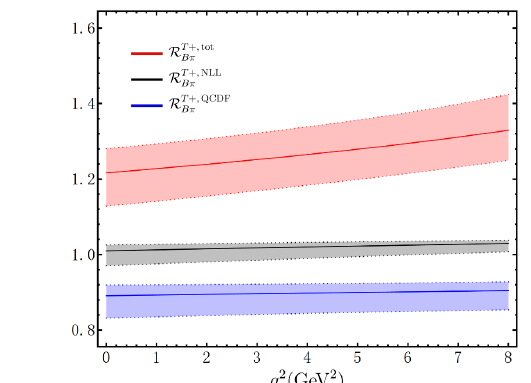
( q 2 ) [141] as the fundamental Bπ